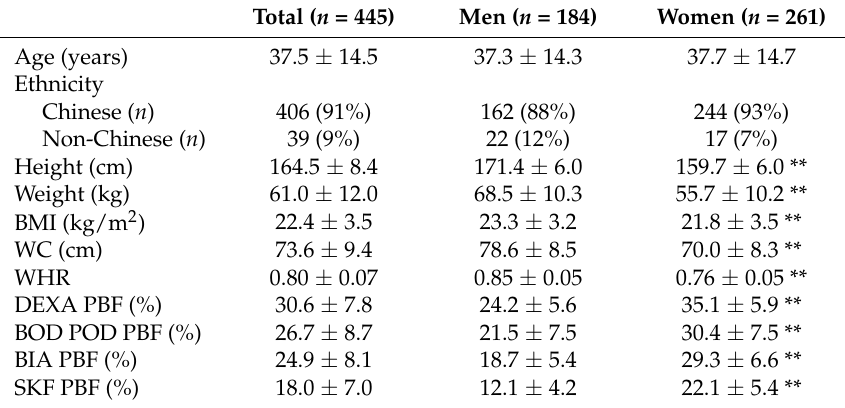
Table 1. Characteristics of the study population.